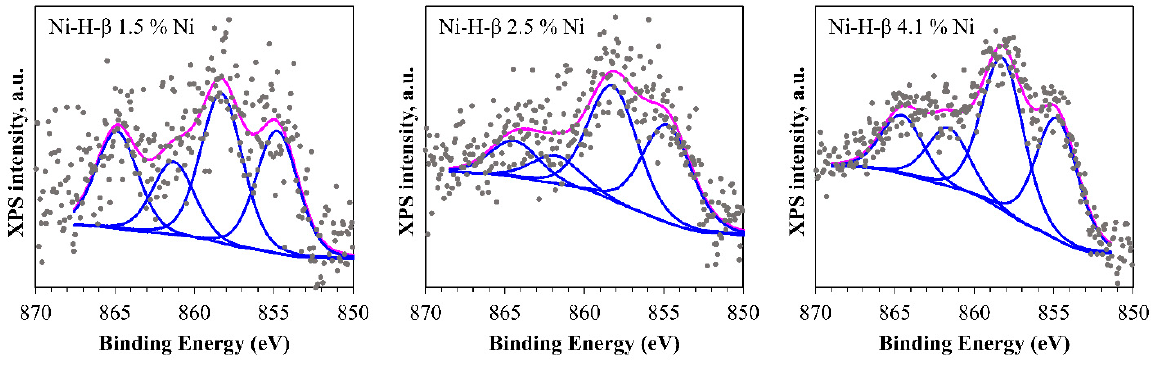
Figure 4. Ni 2p 3/2 X-ray photoelectron spectra of Ni-H-Beta catalysts with nickel loadings of 1.5, 2.5, and 4.1 wt. %. Gray points: measured XPS; blue lines: fitting of individual peaks; purple line: sum of the fitted peaks.